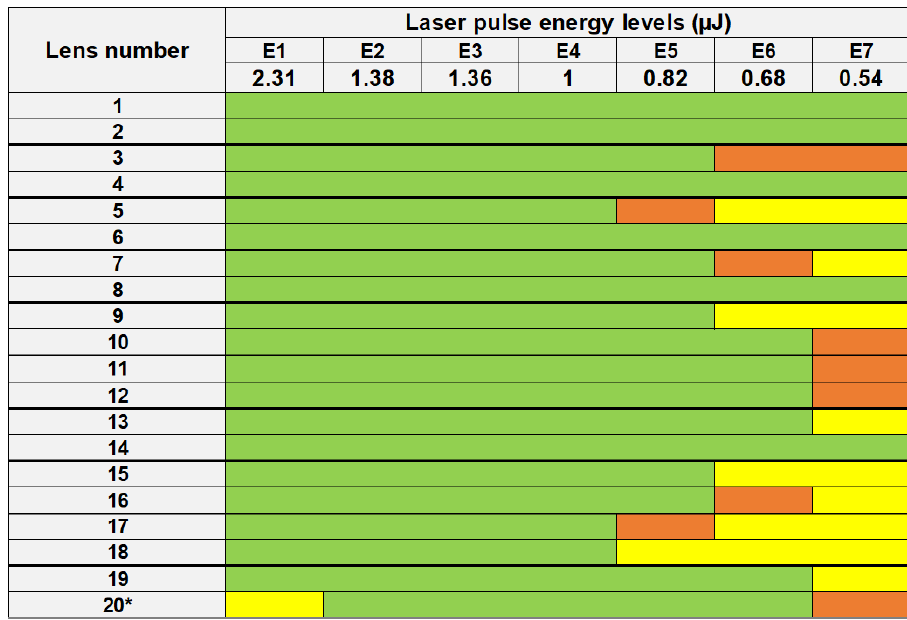
Figure 3. List of lenses treated by laser-pulse energy levels from 2.31 µJ (E1) to 0.54 µJ (E7). Marked bubbles with detectable coalescence (green), small and sparsely located bubbles (orange), and no bubbles but macroscopically opaque (yellow) are shown for each lens. A quite uniform opacification without bubbles was observed at 2.31 µJ (E1) for lens no. 20*. Pairs of lenses are separated by bold lines.